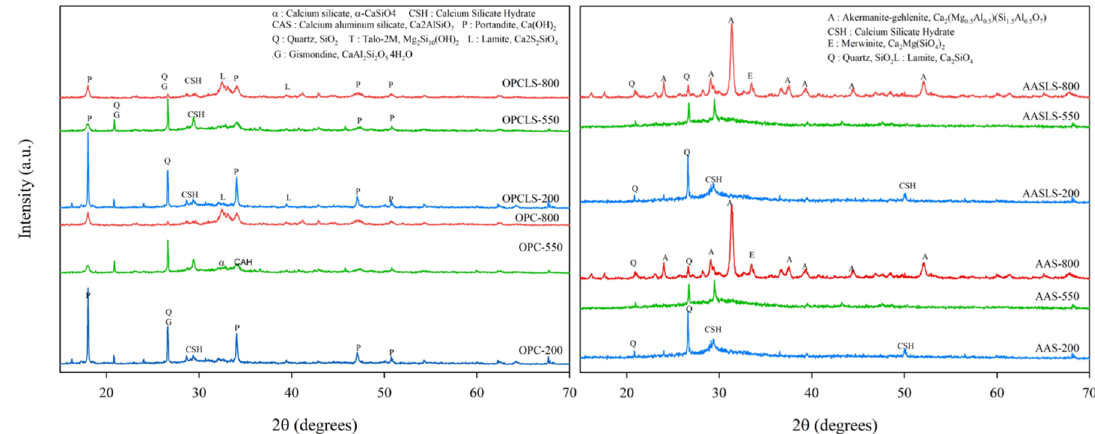
Figure 5. XRD patterns of OPC, OPCLS, AAS, and AASLS at various temperatures.